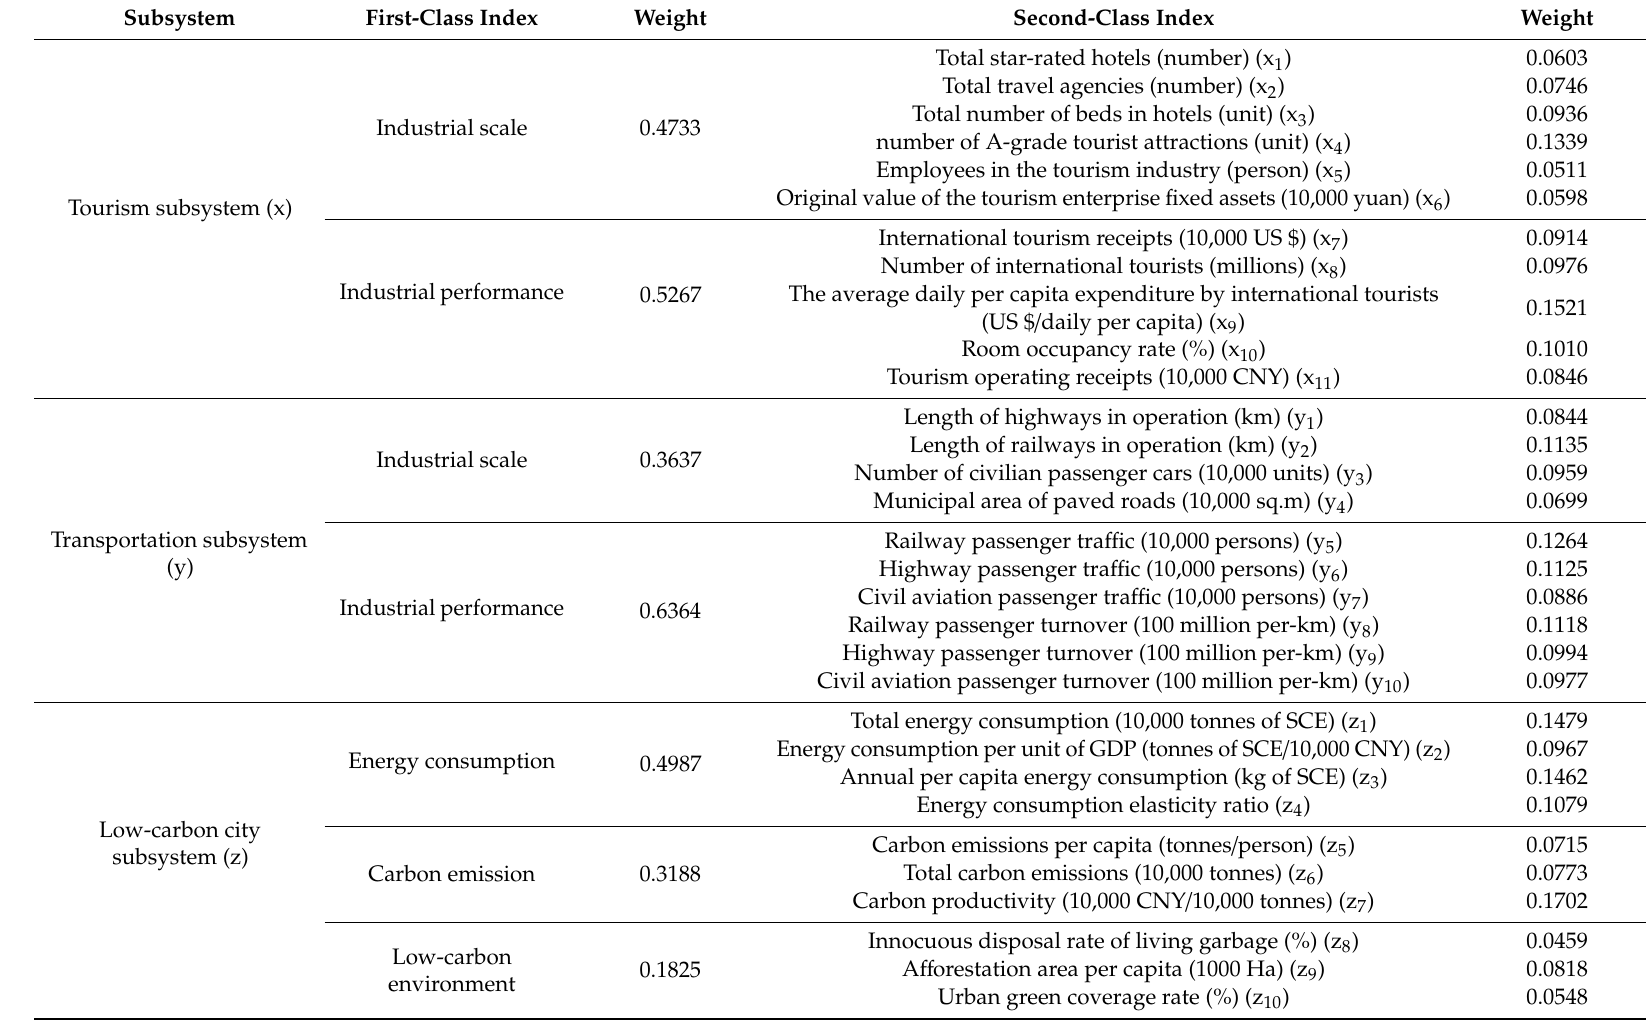
Table 3. Index weights for the three